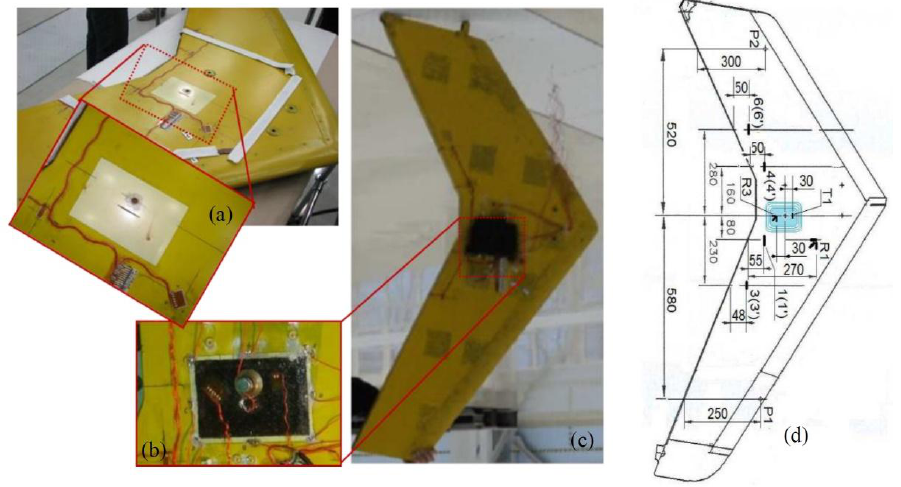
Figure 6. Illustration of the wing and its schematic representation analysed with LIT, from [73]. Unit measures in Figure 6d are in mm.